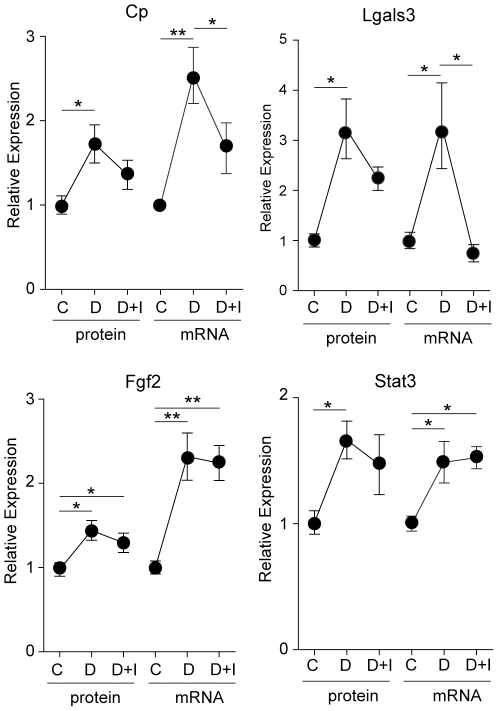
Responsiveness of protein expression to insulin therapy.To examine the effect of insulin treatment on protein and mRNA expression of targets confirmed in the previous experiments, an independent animal experiment was performed with the addition of an insulin-treated diabetic group that received insulin for 1.5 months after 1.5 months of diabetes without insulin therapy. Increased retinal protein and mRNA expression of Cp, Lgals, Fgf2, and Stat3 was observed. Partial normalization of protein expression by insulin treatment was observed for Cp, Lgals3, and Stat3, i.e., expression of those proteins in the insulin-treated group was not significantly different compared to either the control or untreated diabetic group. Fgf2 protein expression remained significantly elevated in the insulin treated group compared to controls. mRNA expression responsiveness was more complex with Lgals3 mRNA levels completely normalized, Cp mRNA levels partially normalized, and Fgf2 and Stat3 levels remaining elevated. C = Control, D = Diabetic, D+I = Diabetic with insulin, * p<0.05, ** p<0.01, one-way ANOVA, Student Newman Keuls post-hoc test.